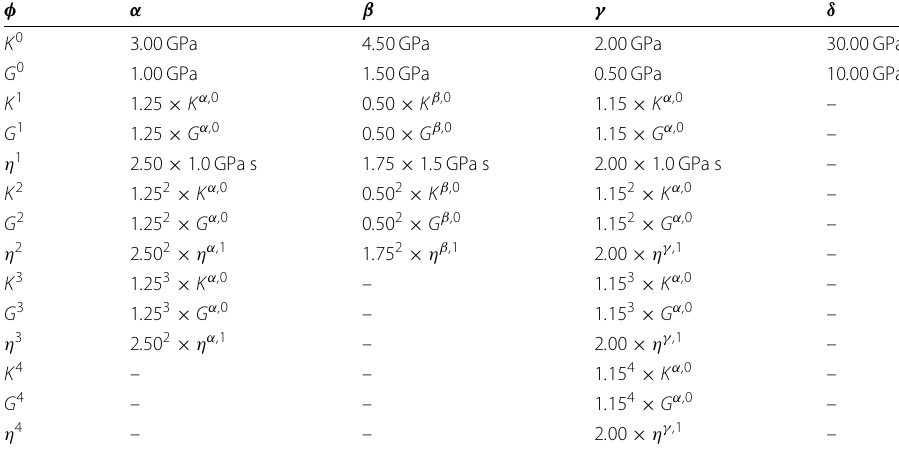
Table 6 Multiphase region: Material